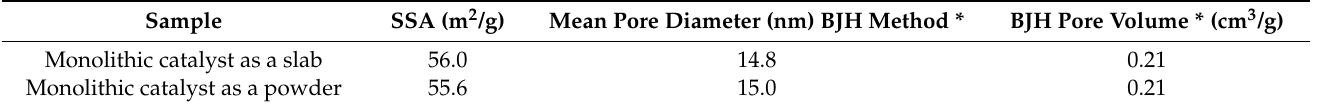
Table 4. Textural properties of the monolithic